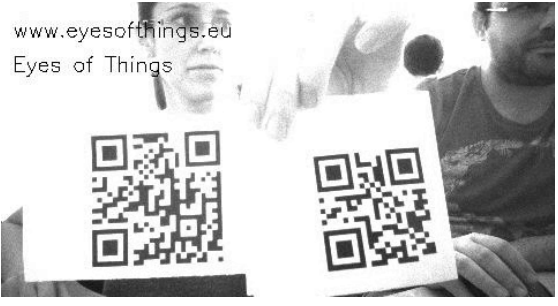
Figure 15. QR code recognition. In this image, two QR codes are